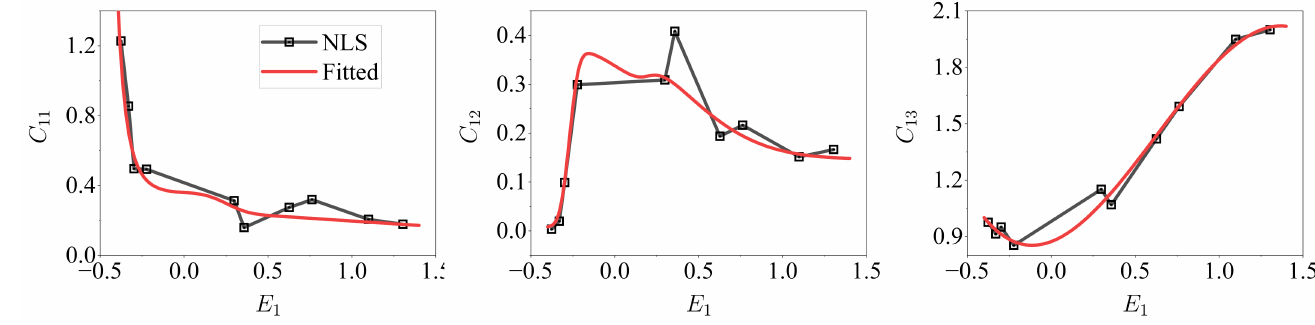
(cid:16) (cid:17) d rj